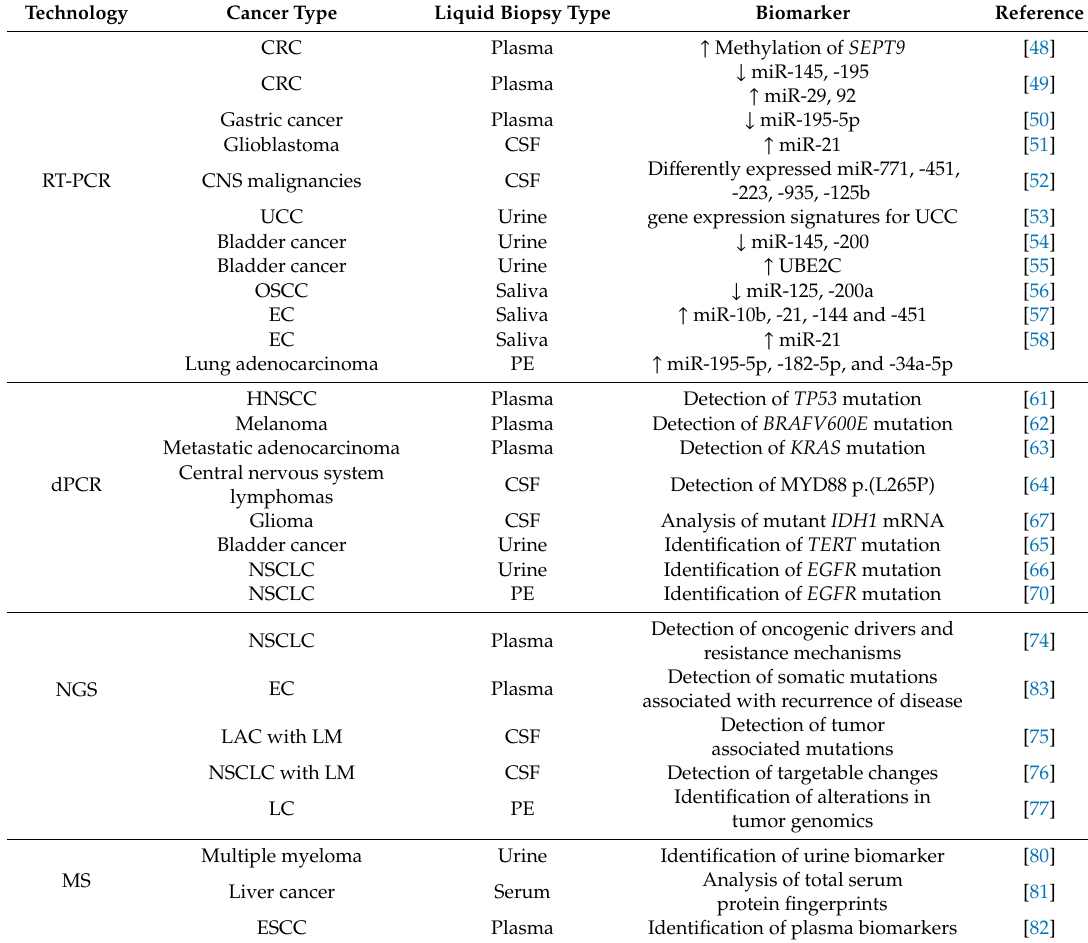
Table 1. Detailed description of the advanced liquid biopsy technologies in cancer management.